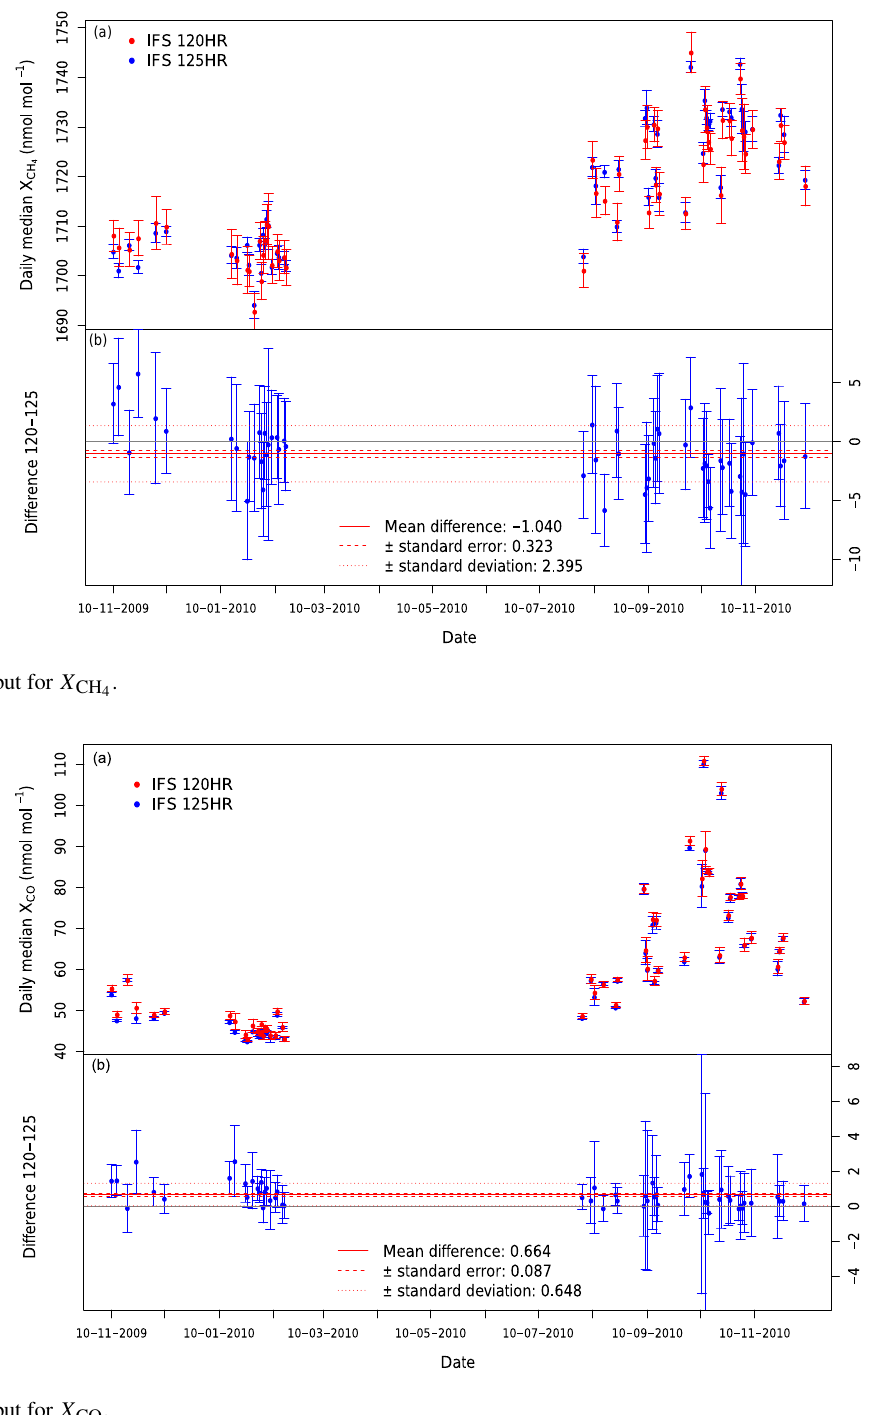
Figure 8. As Fig. 6 but for X CO